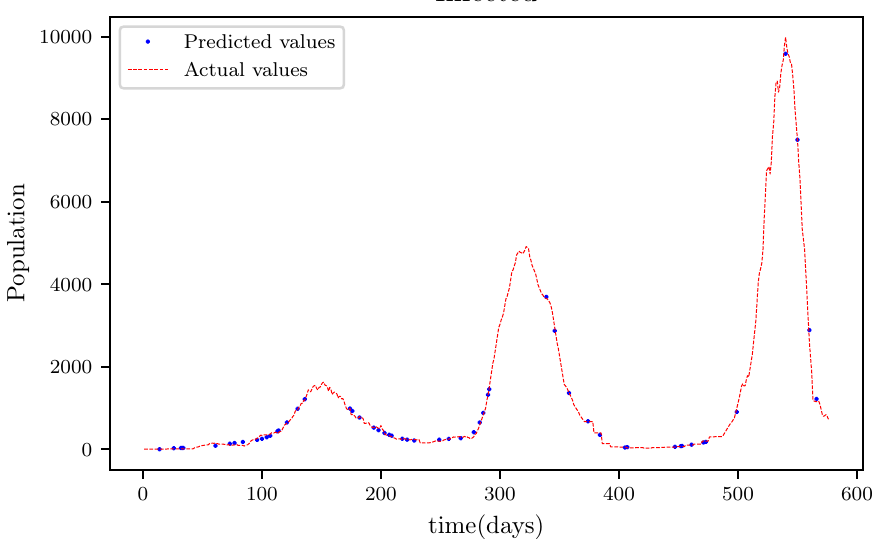
Figure 12. The graph shows a comparison of the predicted infected population values and the actual data of the infected population for a 130 data